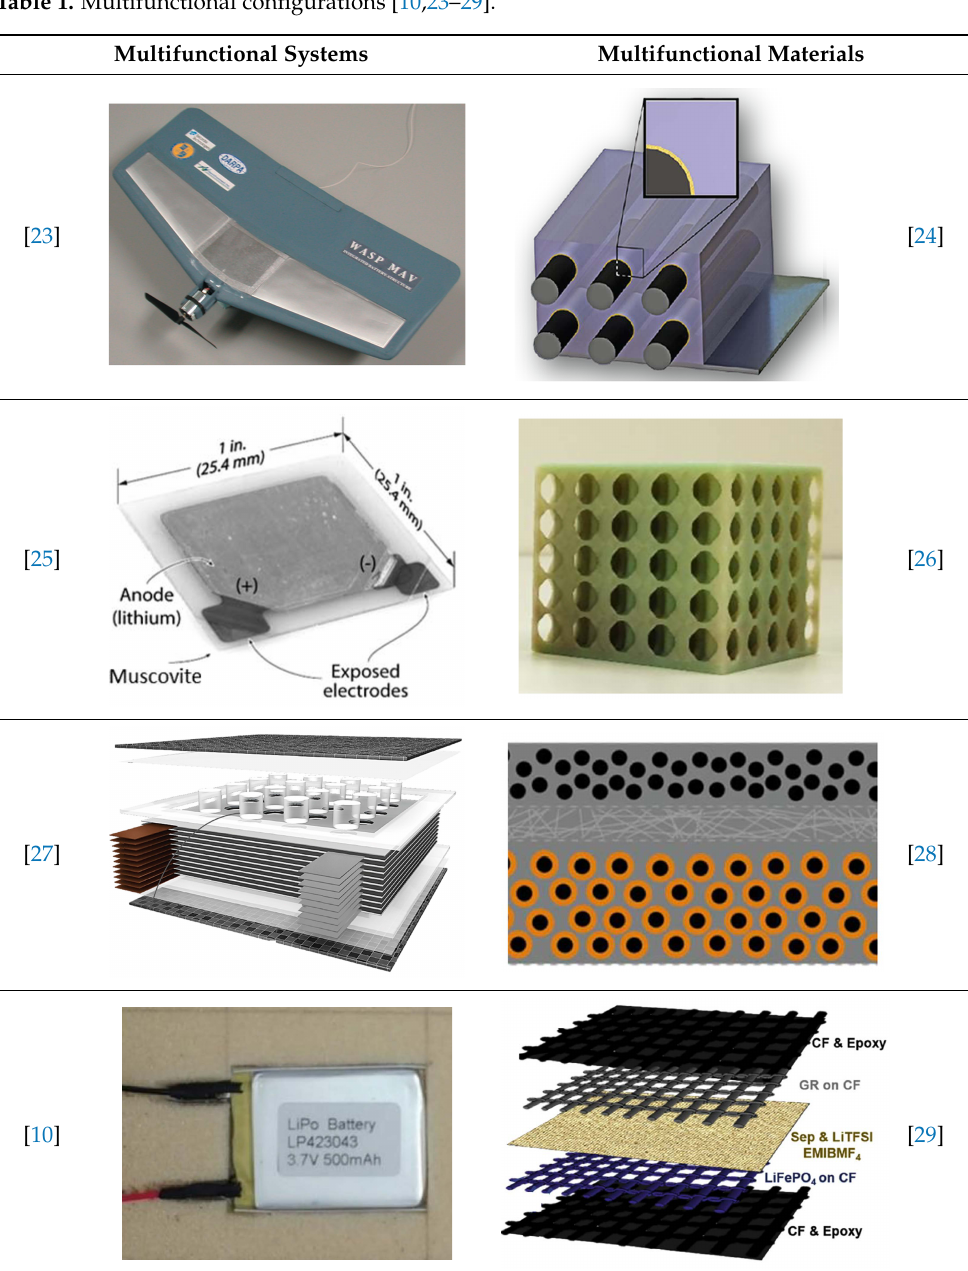
Table 1. Multifunctional configurations